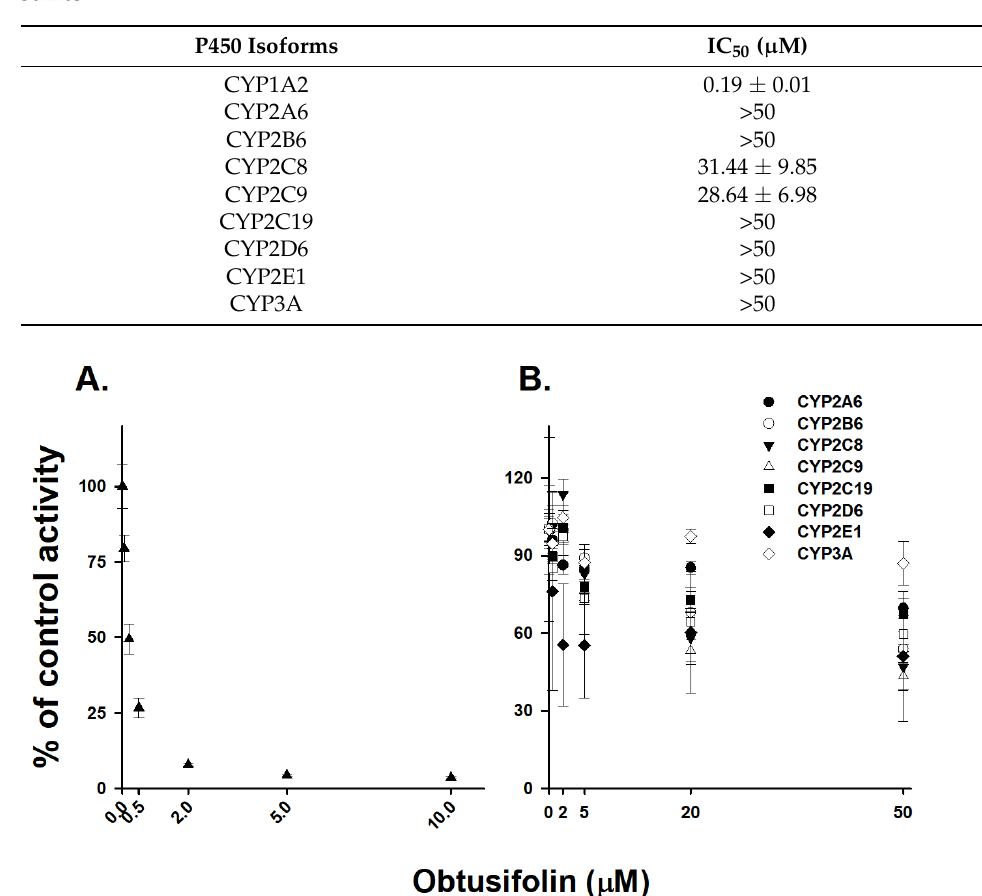
Table 4. Inhibitory effects of obtusifolin against nine cytochrome P450 isoforms in human liver microsomes.